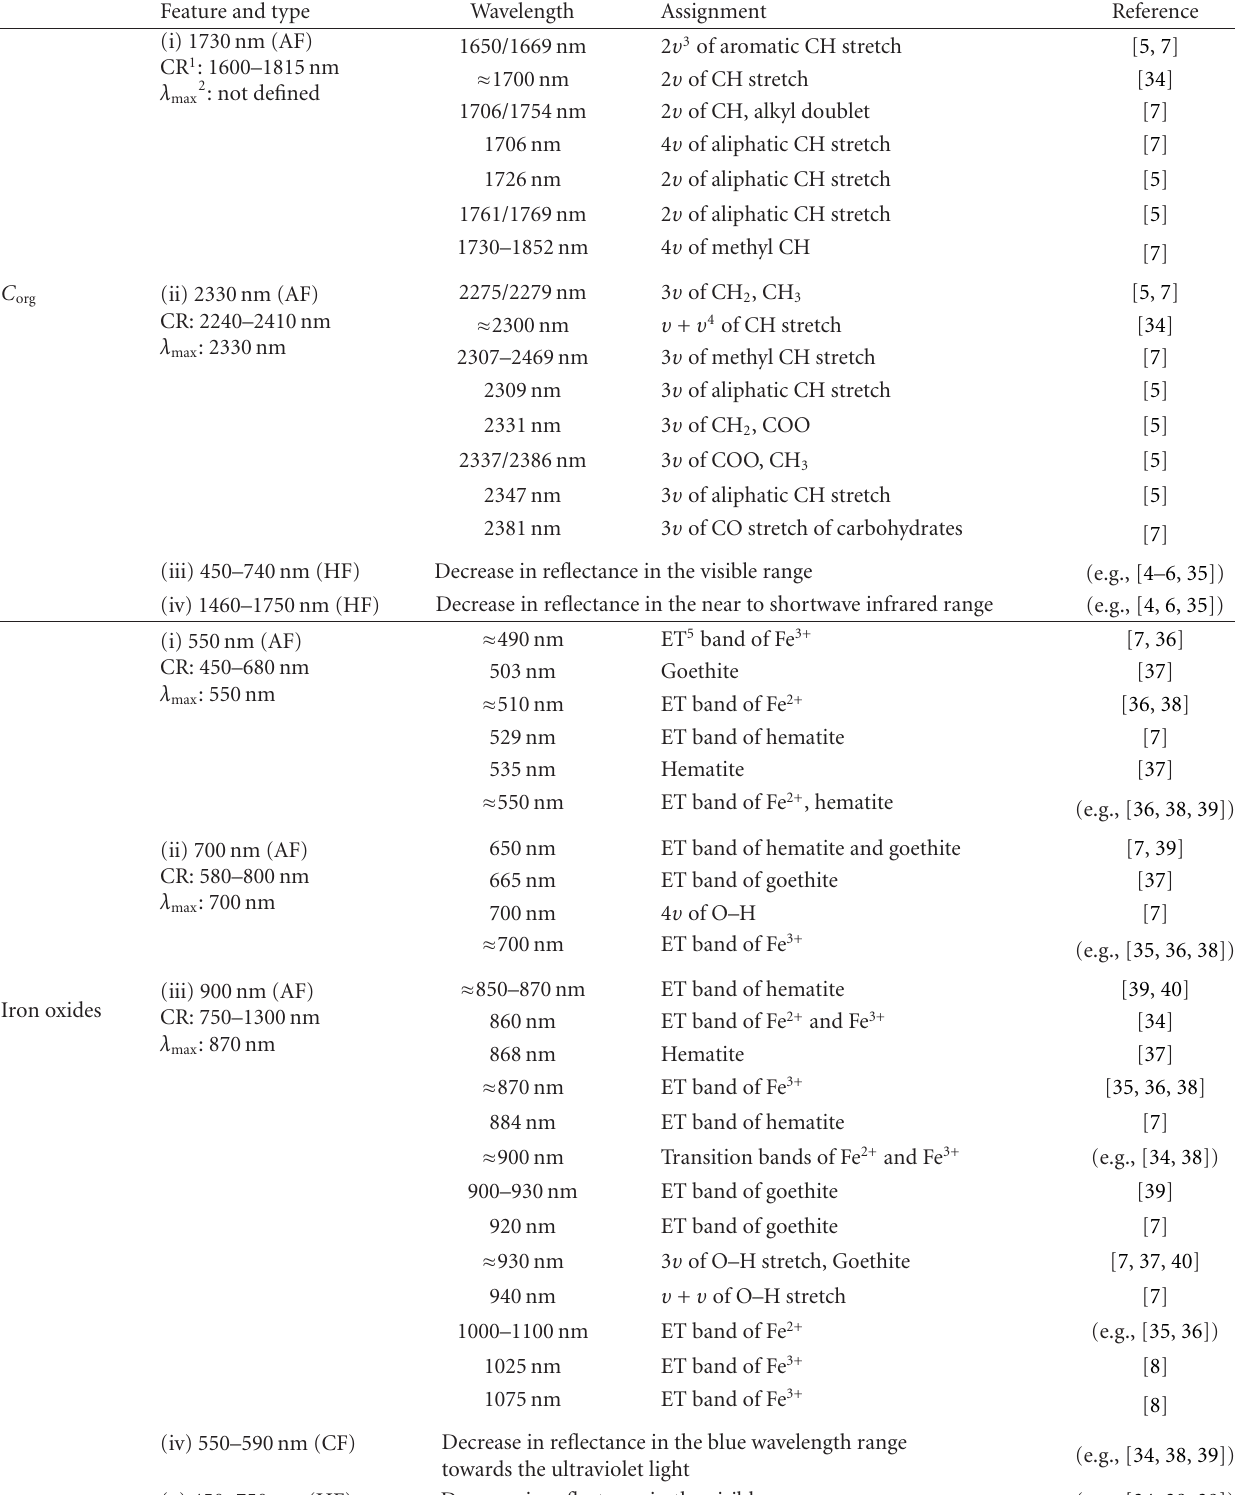
Table 1: Spectral features that are used for the delineation of soil organic carbon, iron oxides and clay content within approach A. References to studies previously describing these spectral characteristics are